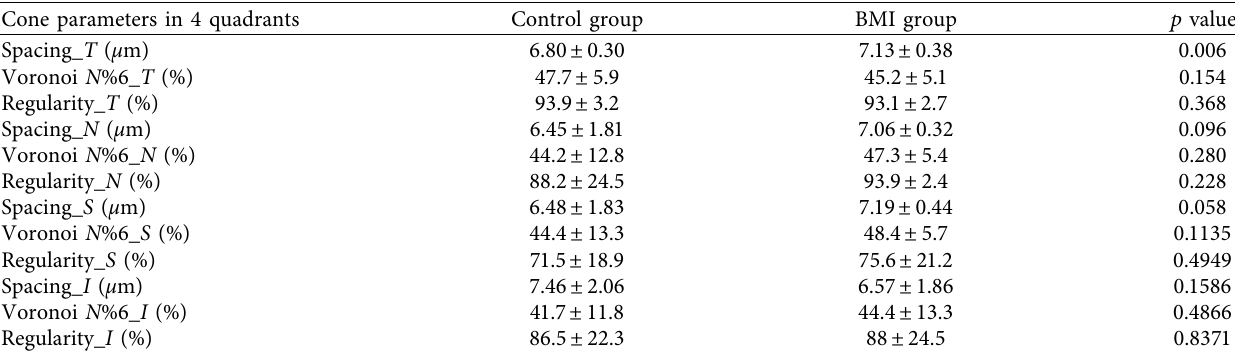
Table 5: Mean ( ± SD) spacing, Voronoi, and cone regularity in Control and BMI groups in 4 quadrants after Bonferroni correction (adjusted p value � 0.0042).